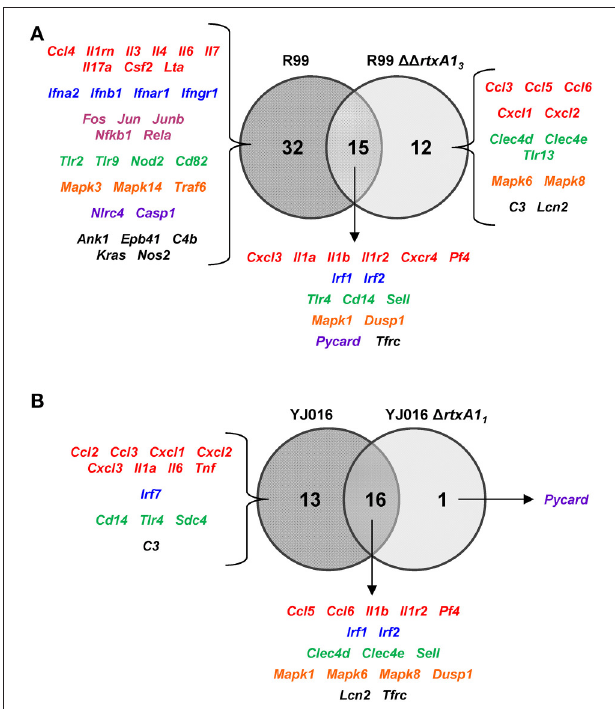
FIGURE 6 | Role of RtxA1 in the induction of the host immune response and CSK. Venn diagram depicting the overlap of the genes that are differently up-regulated between (A) R99 and R99 11 rtxa1 3 , and (B) YJ016 and YJ016 1 rtxA1 1 infected-mice for 4 h. Only genes up-regulated more than 1.3 were